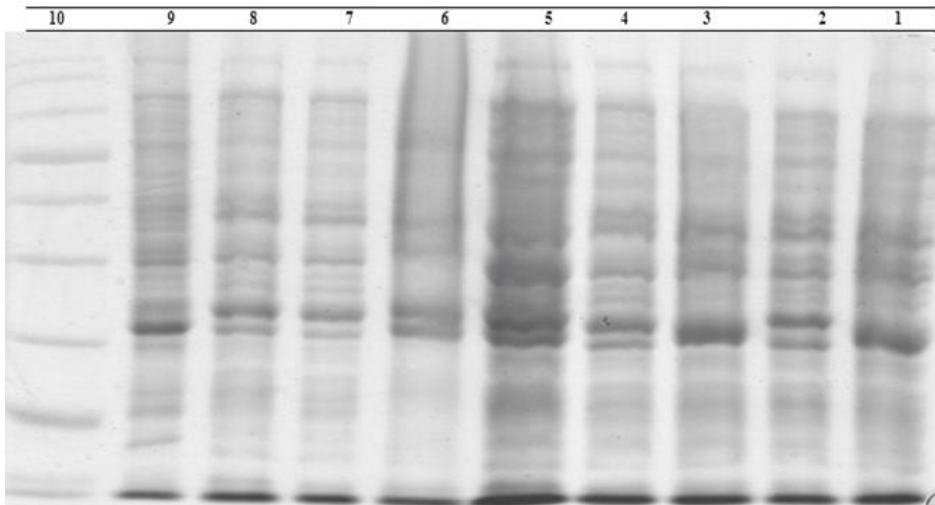
Figure 4. Sodium dodecyl sulfate – polyacrylamide gel electrophoresis whole-bacteria protein profiles of E. coli strains from milk after the thermal shock. Lane 1, E. coli strain 77; Lane 2, E. coli strain 140; Lane 3, E. coli strain 143; Lane 4, E. coli strain 119; Lane 5, E. coli strain 153; Lane 6, E. coli strain 8; Lane 7, E. coli strain 126; Lane 8, E. coli strain 14; Lane 9, reference strain E. coli ATCC 25922; and Lane 10, marker.